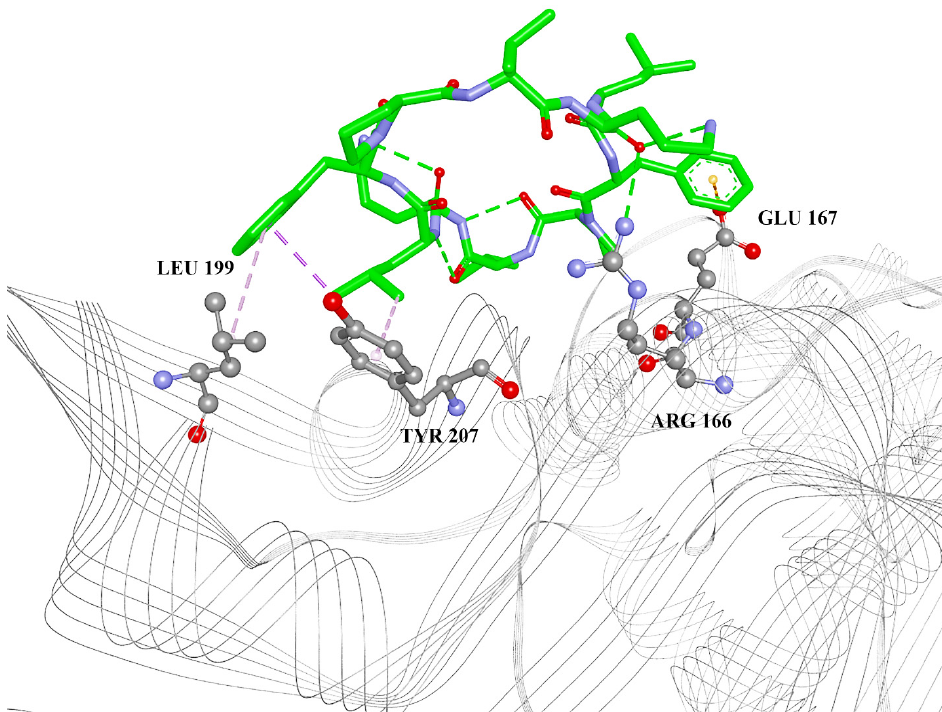
Figure 2. Gramicidin S docked into the catalytic site of PL pro . Green lines: hydrogen bonds; orange: electrostatic (including Pi ‐ anion); yellow: Pi ‐ sulfur; magenta: Pi ‐ alkyl.